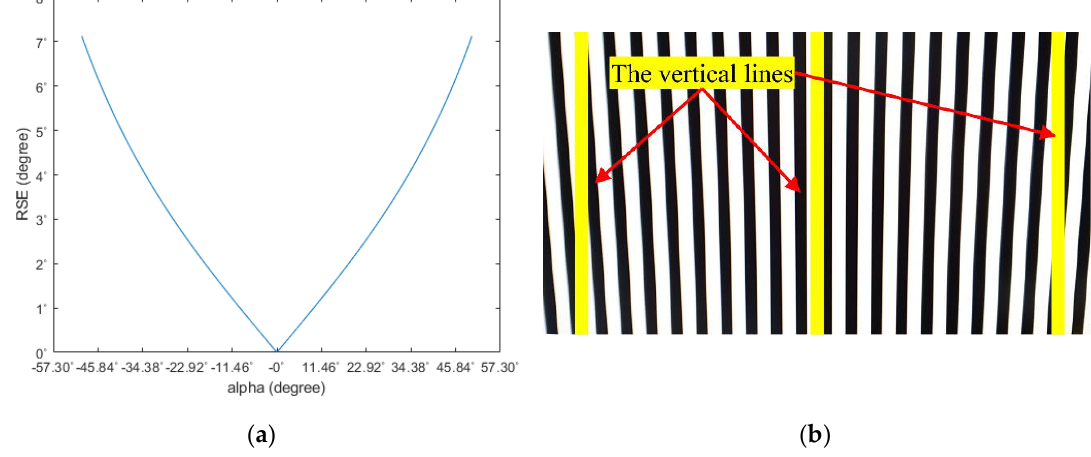
Figure 9. RSE occurrence test result: ( a ) simulation data using arbitrarily set parameters and ( b ) the image taken when the camera movement is perpendicular to the image plane.